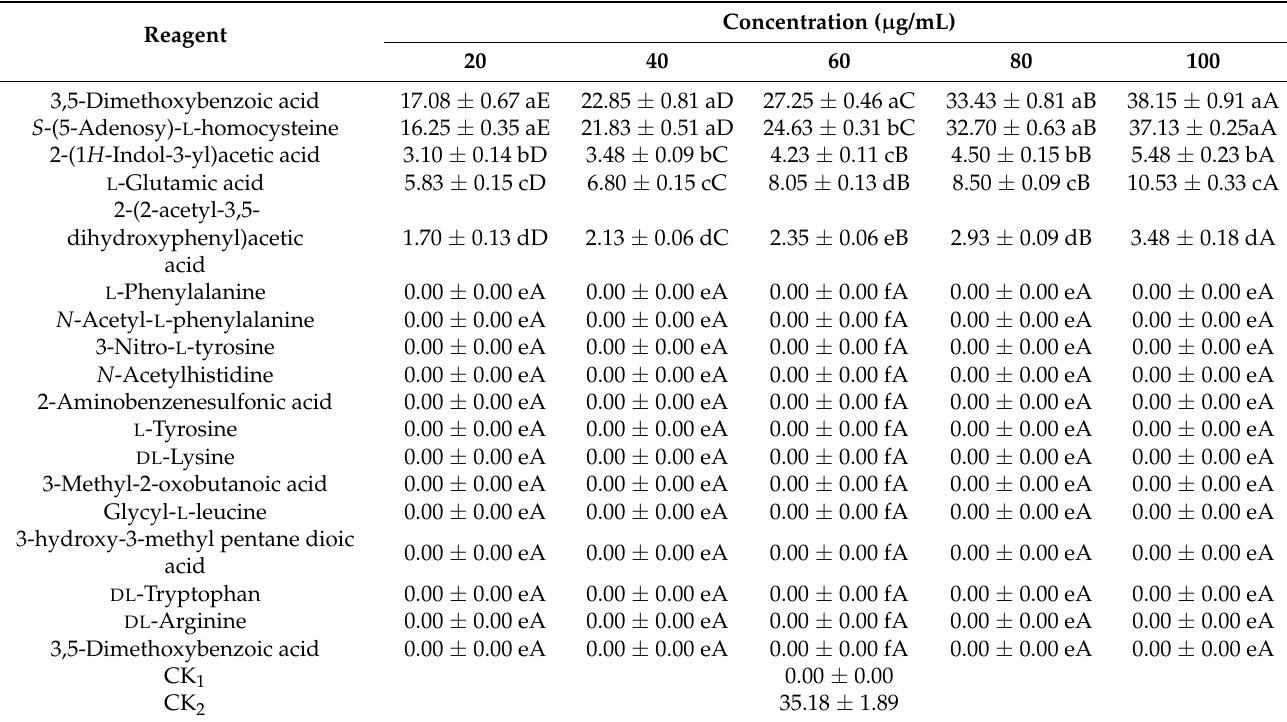
Table 3. Effects of different reagents and their concentrations on the lesion area of Z. schinifolium